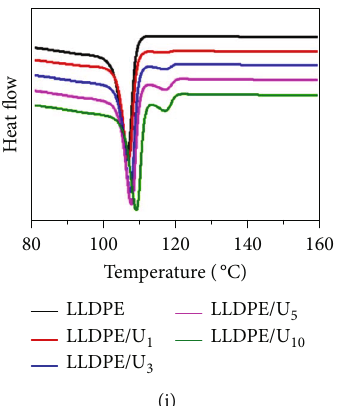
Figure 9: DSC curves of three kinds of blends. (a – c) The second heating scan of PP/U, EPDM/U, and LLDPE/U. (d) Melting enthalpy of PP/U. (e, f) The crystallinity of EPDM/U and LLDPE/U. (g – i) The second cooling scan of PP/U, EPDM/U, and